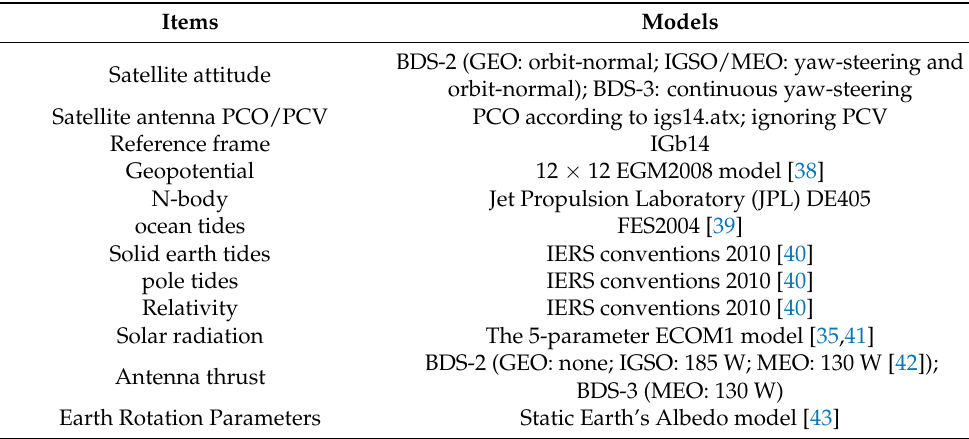
Table 1. Processing strategies of WHU BDS precise orbit determination